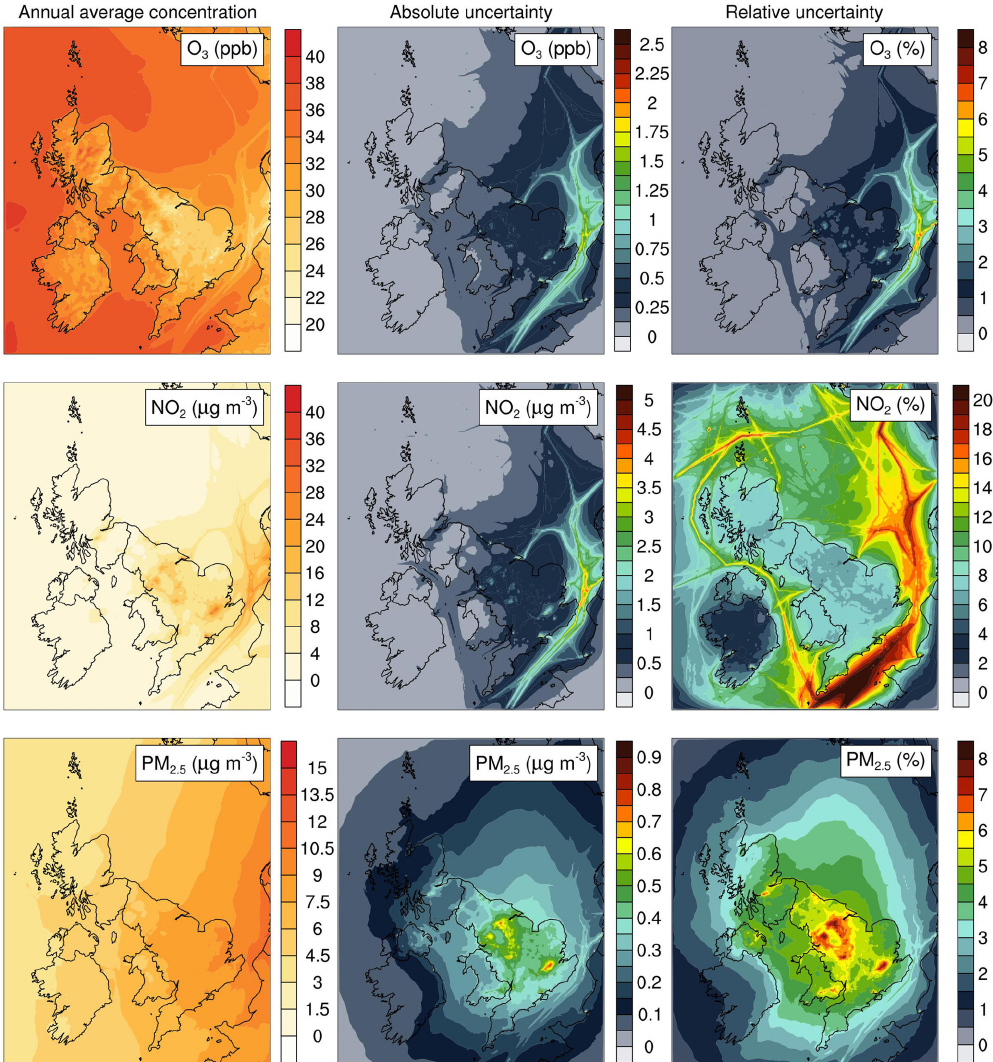
Figure 2. Baseline surface concentrations of O 3 , NO 2 , and PM 2 . 5 and their respective spatial distributions of absolute and relative uncer- tainties (at the 5km × 5km model grid resolution, year 2012) for the specified uncertainties in UK emissions. The uncertainty values are represented as a range ± the baseline value and represent the 95% confidence